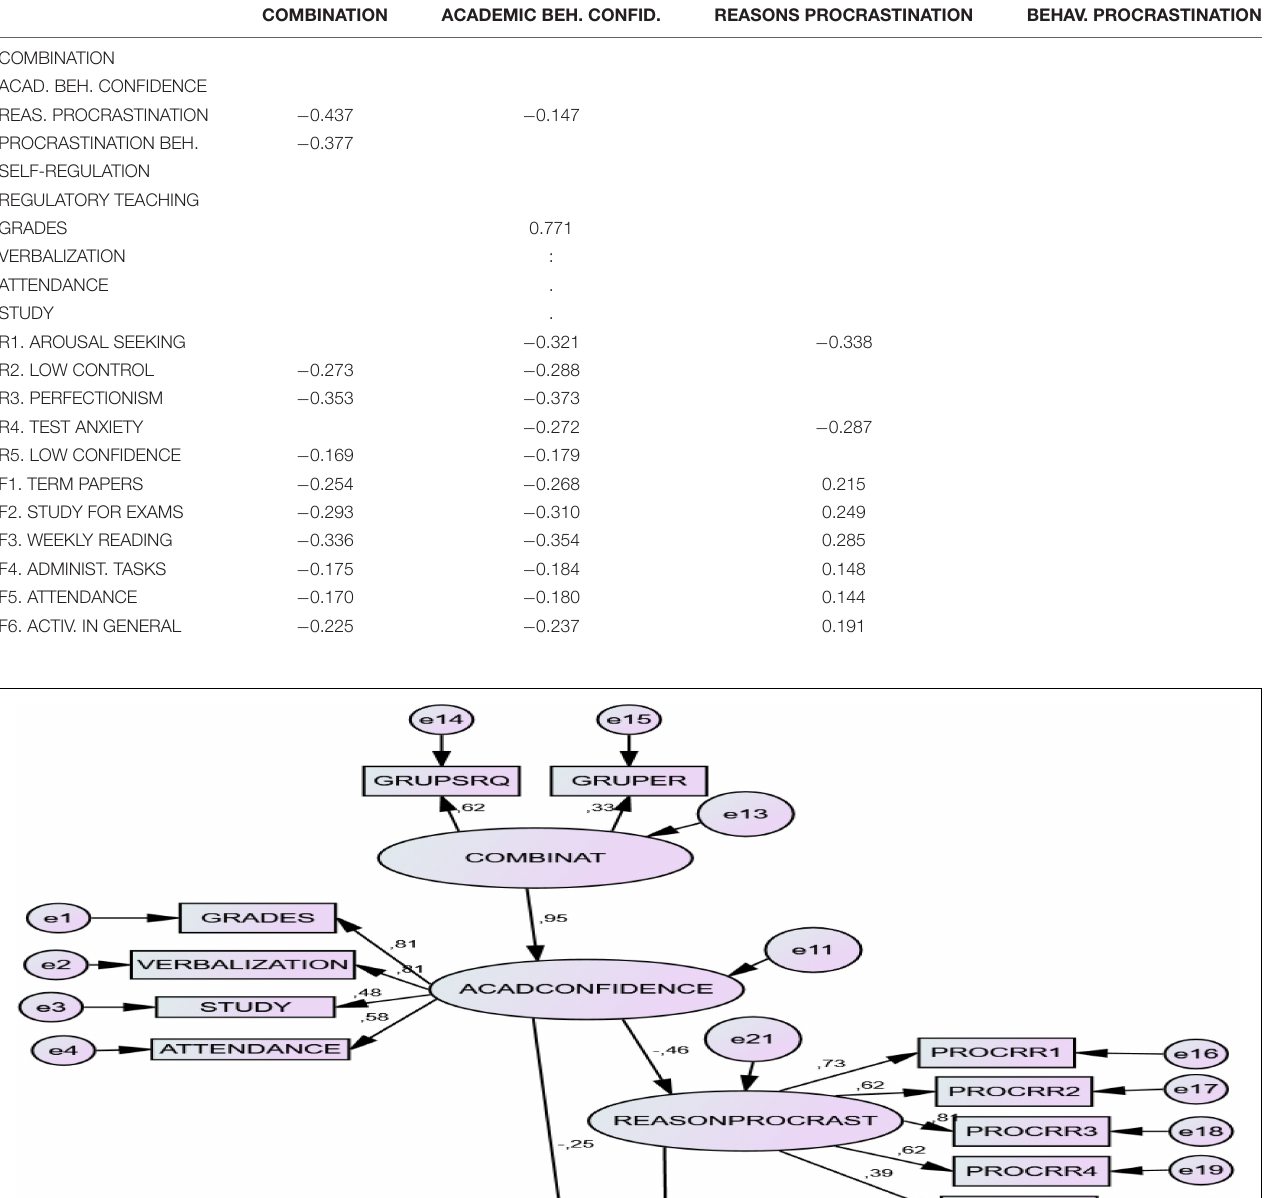
TABLE 6 | Standardized indirect effects (default model).